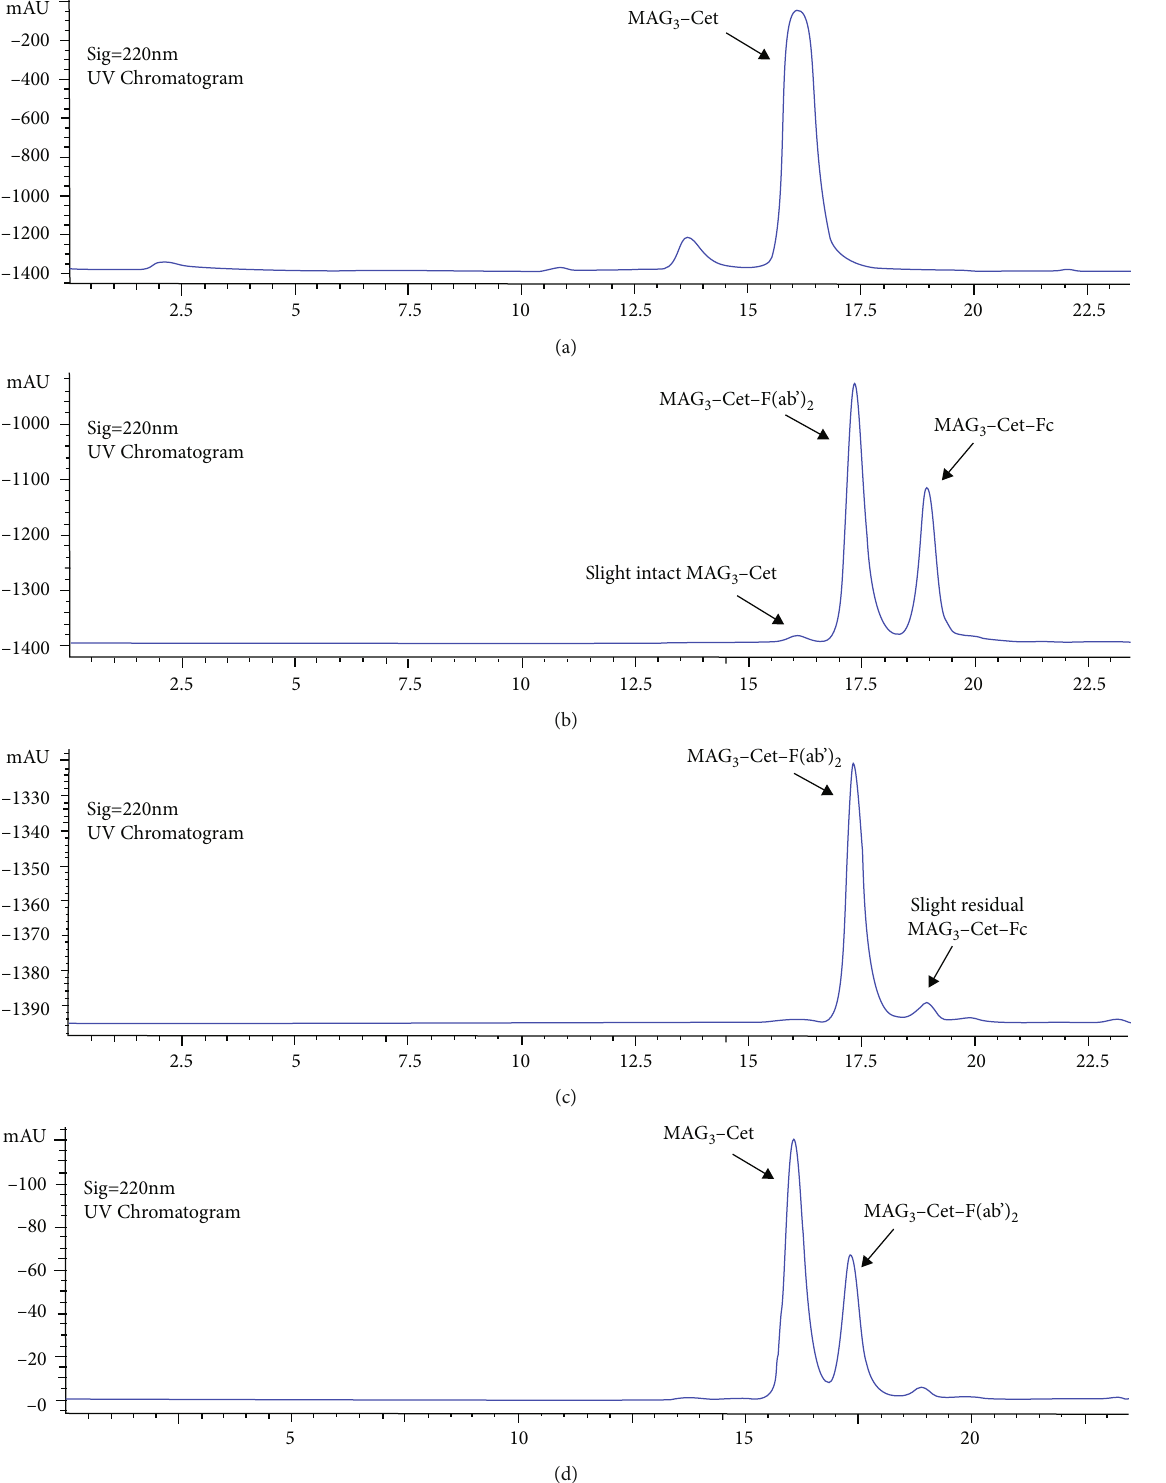
-Cet, MAG -Cet-F(ab ′ ) and MAG -Cet-Fc. (a) The HPLC result of 3 3 2 3 -Cet-F(ab ′ ) and MAG -Cet-Fc after digesting MAG -Cet with IdeS protease. (c) The HPLC 3 2 3 3 -Cet and most of the MAG 3